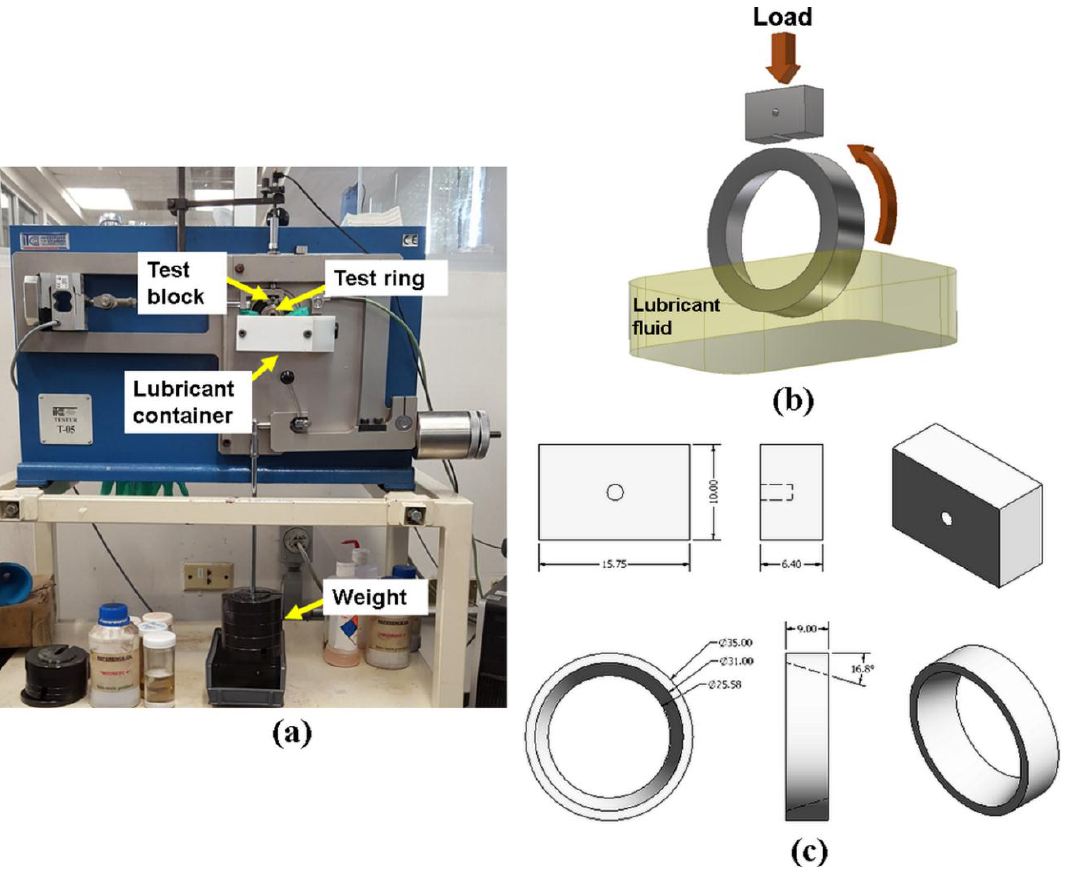
Figure 3. ( a ) T-05 Block-on-ring tribotester; ( b ) Schematic of the block-on-ring setup showing the direction of the applied force; ( c ) Dimensions of the test block and ring.